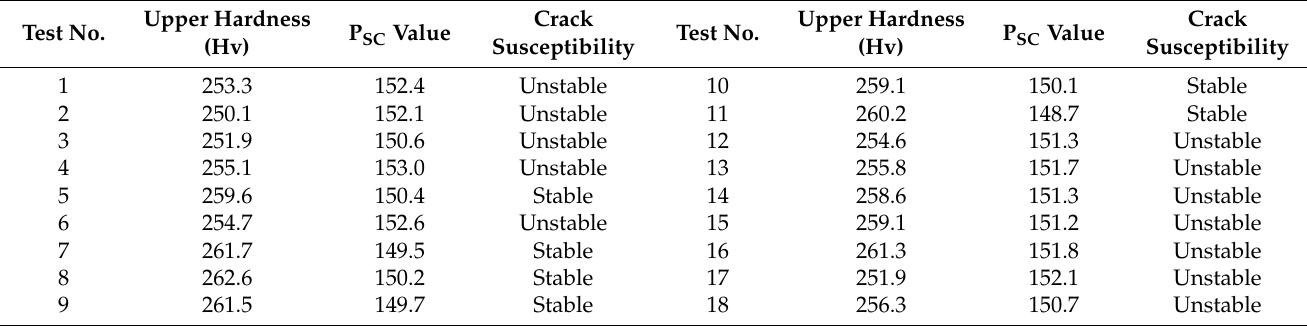
Table 8. Solidification crack susceptibility data.